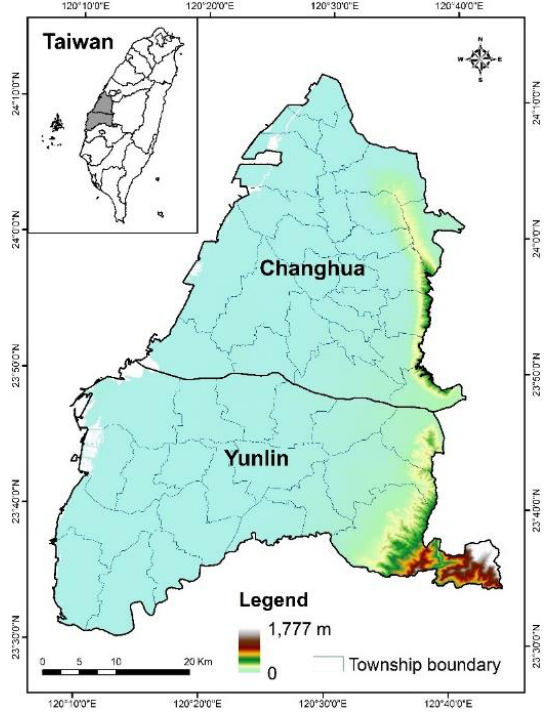
Figure 1. The location of the study region showing different elevation levels obtained from the ASTER DEM with a reference to the geography of Taiwan.